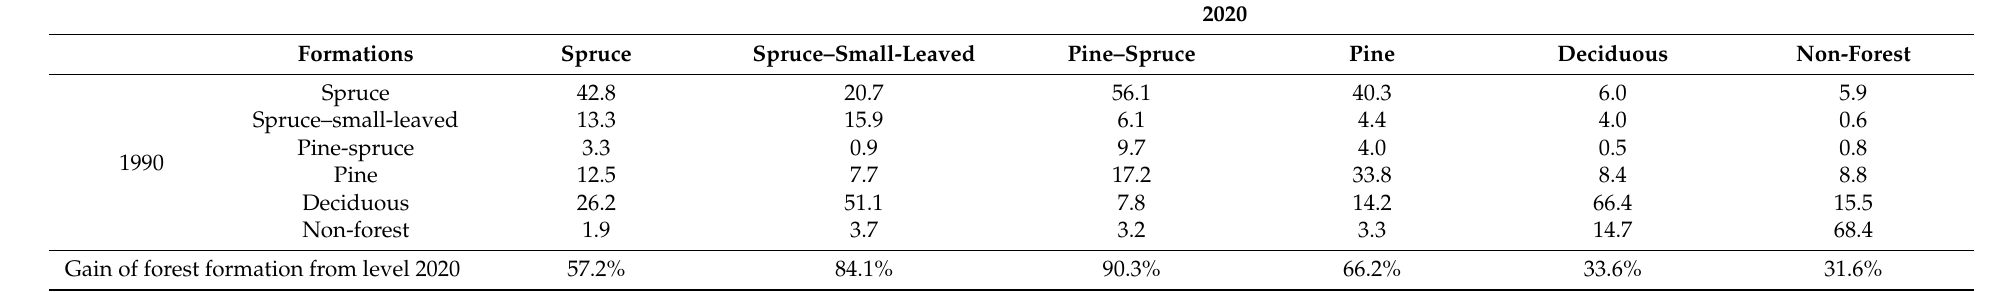
Table A5. Changes in the composition of coniferous formations in the period 1990-2020, gain of the area of forest formations relative to the 2020 level,